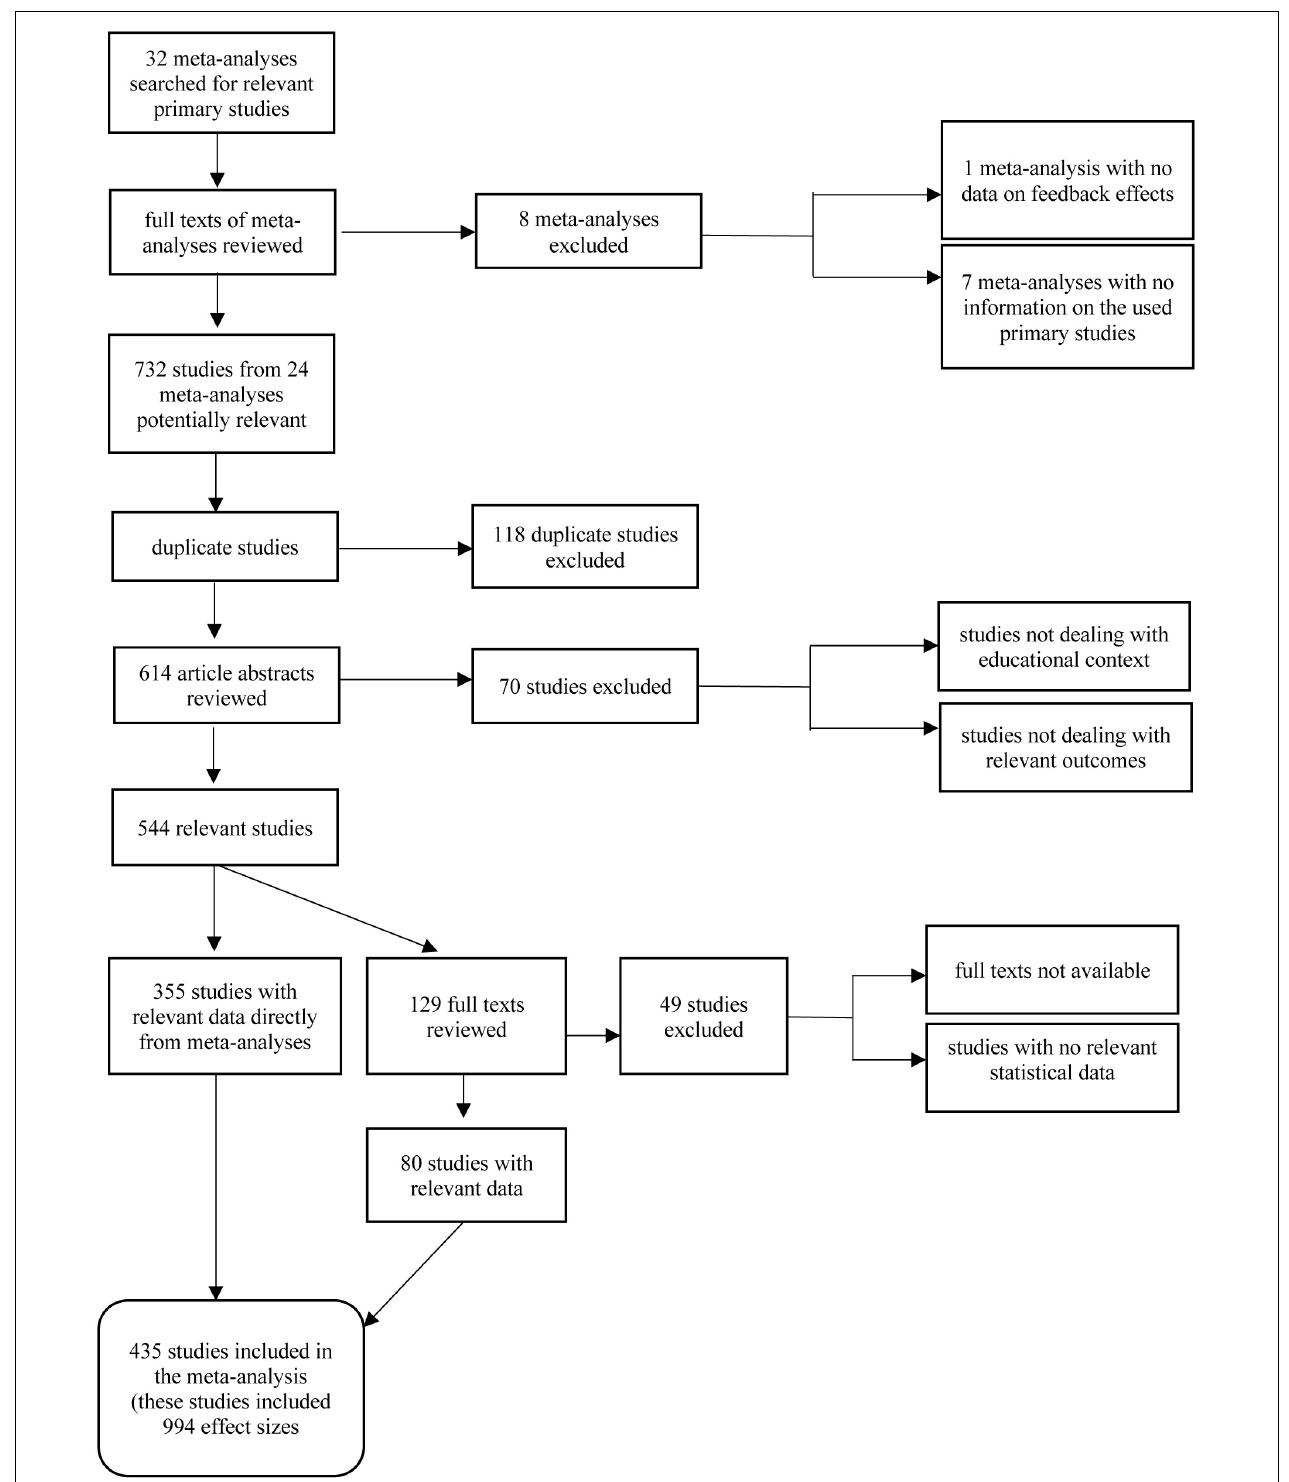
FIGURE 1 | Flow diagram of study identification and